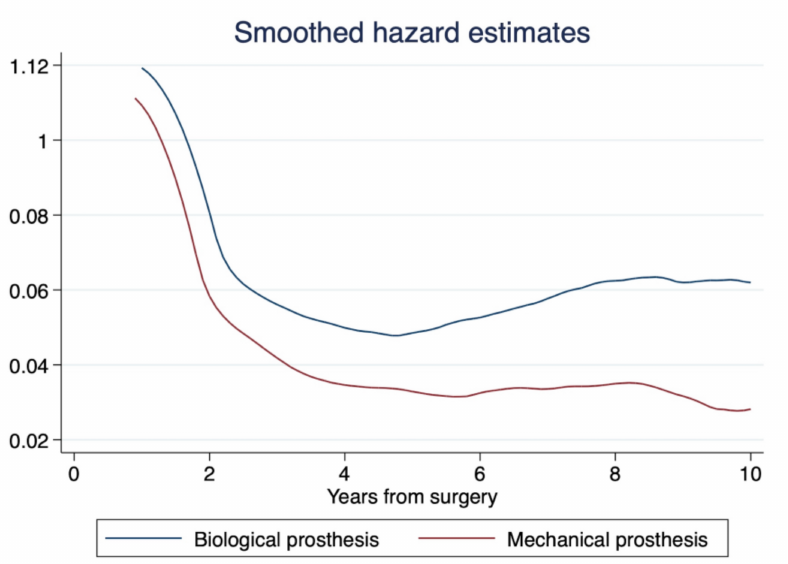
Figure 5. Smoothed hazard function of the all databases pooled in one global